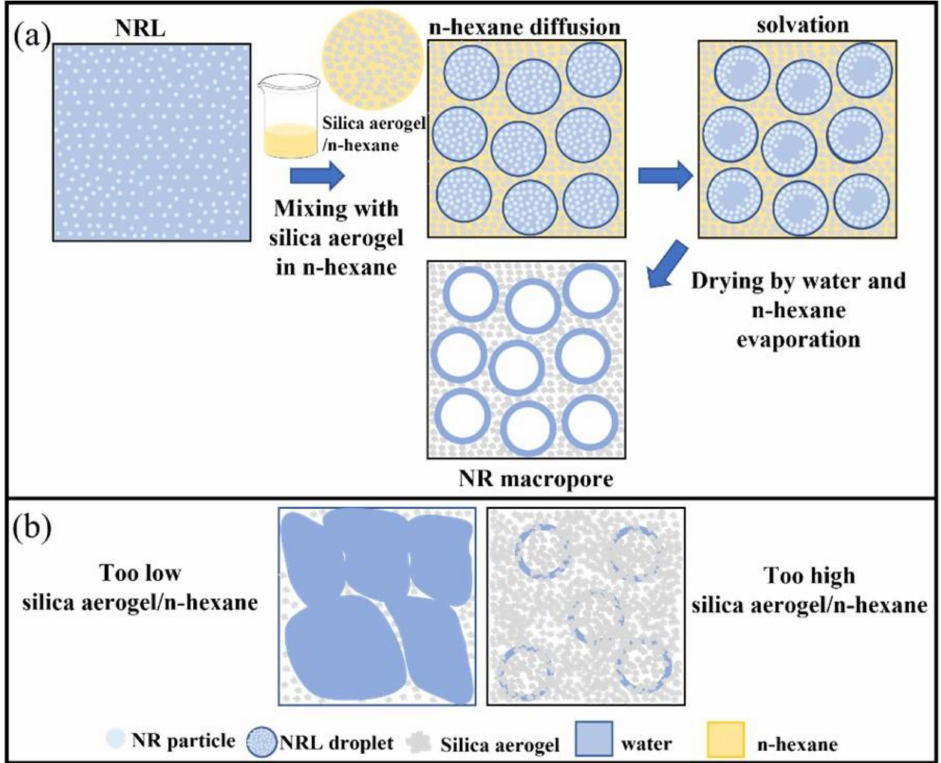
Figure 4. Schematic representation of ( a ) NR macropore formation in silica aerogel/NR composite and ( b ) effect of silica aerogel content on NR